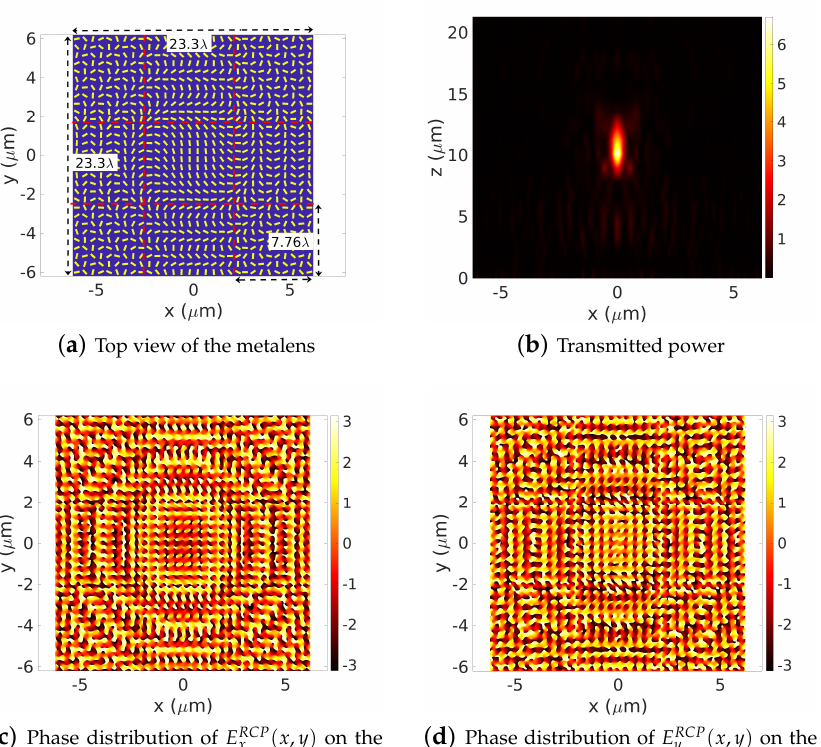
Figure 11. Forward simulation of a Ω = 23.3 λ × 23.3 λ -width Pachatarnam–Berry phase-based metalens. The lens is designed to have a focus length of f = 20 λ . The number of sub-cells and truncation orders are set to 3 × 3 and m x = m y = 12 ( M x = M y = 37), respectively. ( b ) displays the power distribution in the ( x , y = 0, z ) plane. The phase distribution of the co-polarization E RCP x ( x , y ) , E RCP y ( x , y ) components of the emerged RCP electric field at the top face of the metalens, obtained using the direct and the inverse transform, are presented in ( c , d ). A [ − π , π ] coverage is clearly distinguished. Numerical parameters: λ = 0.532 µ m, focus length z s = 20 λ , D x = D y = 23.30 λ , h = 400